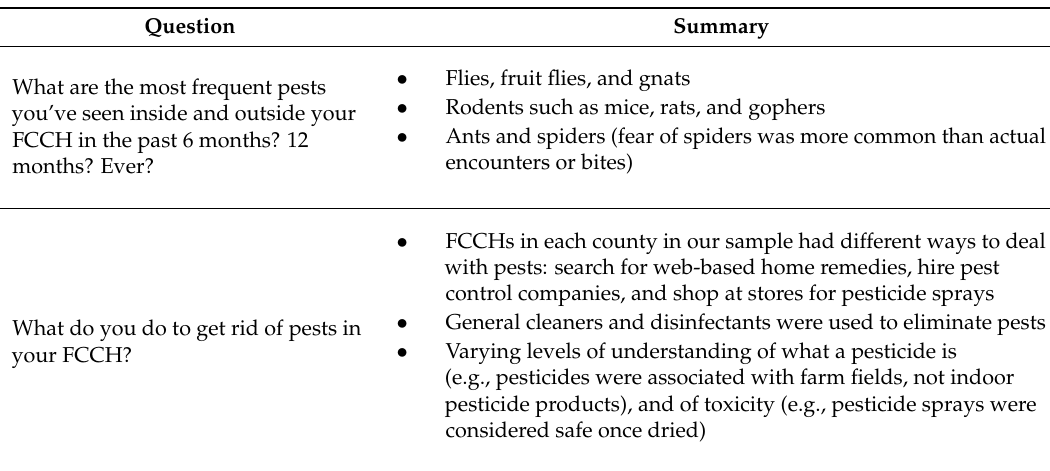
Table 1. Focus Group Themes on IPM Needs and